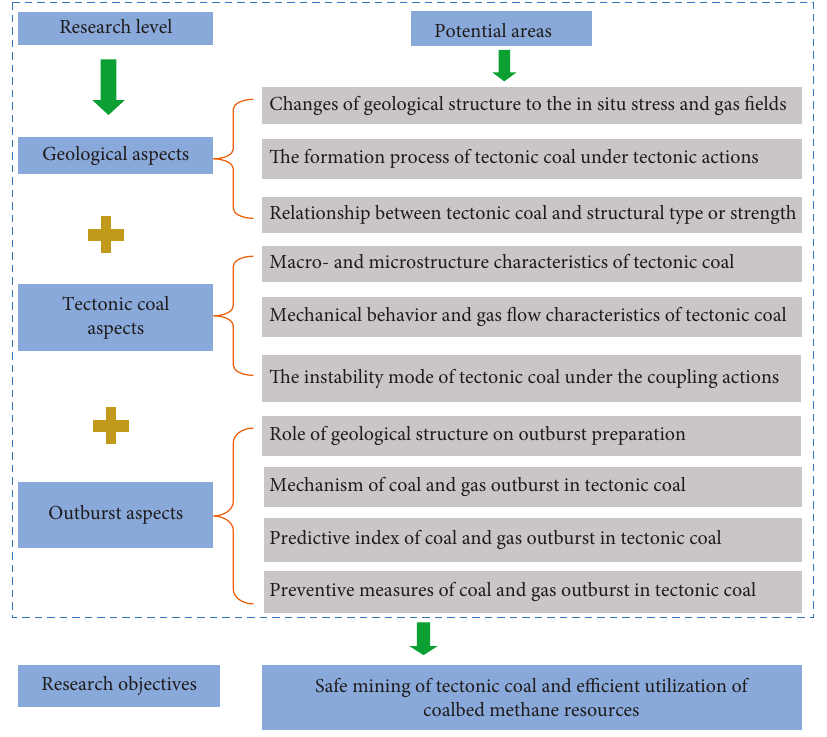
Figure 8: Potential research direction of geological factors of